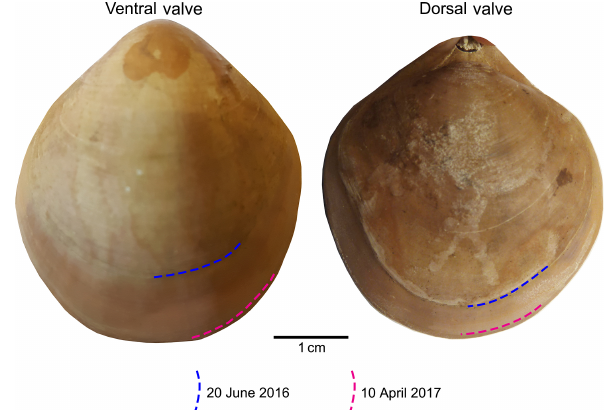
Figure 2. Growth tracked with calcein and marked by blue and red lines on the surface of the brachiopod specimens (no. 9006).